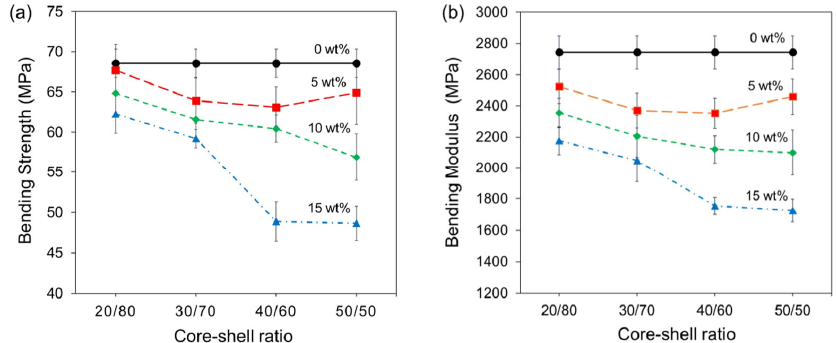
Figure 3. Four-point bending properties of bone cement formulations: ( a ) bending strength and ( b ) bending modulus. Error bars represent the calculated standard deviation.